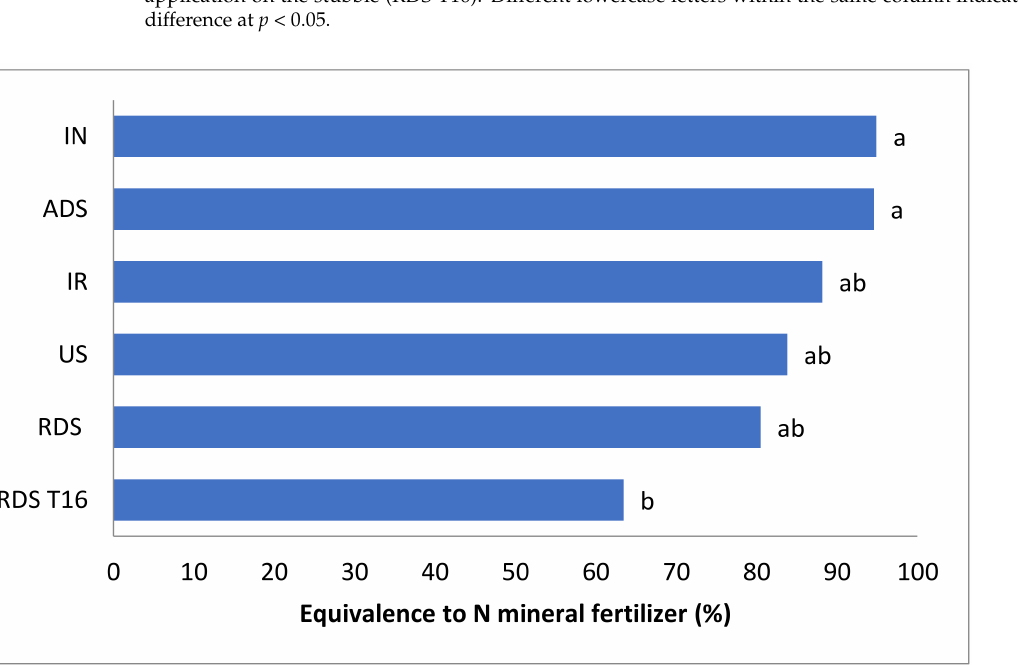
Figure 2. Nitrogen mineral fertilizer equivalence (Means of three replicates). Different letters on the columns indicate significant differences at p < 0.05 for treatments, according to the Tukey